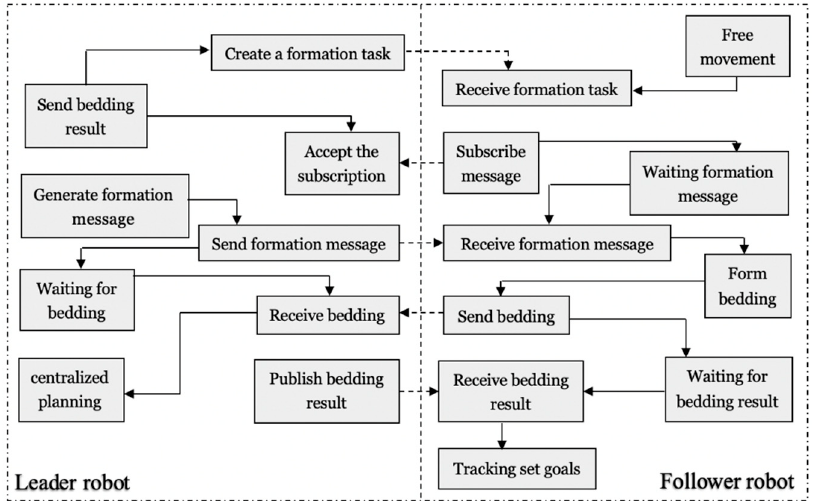
Figure 11. Flow diagram of the auction-based planning.